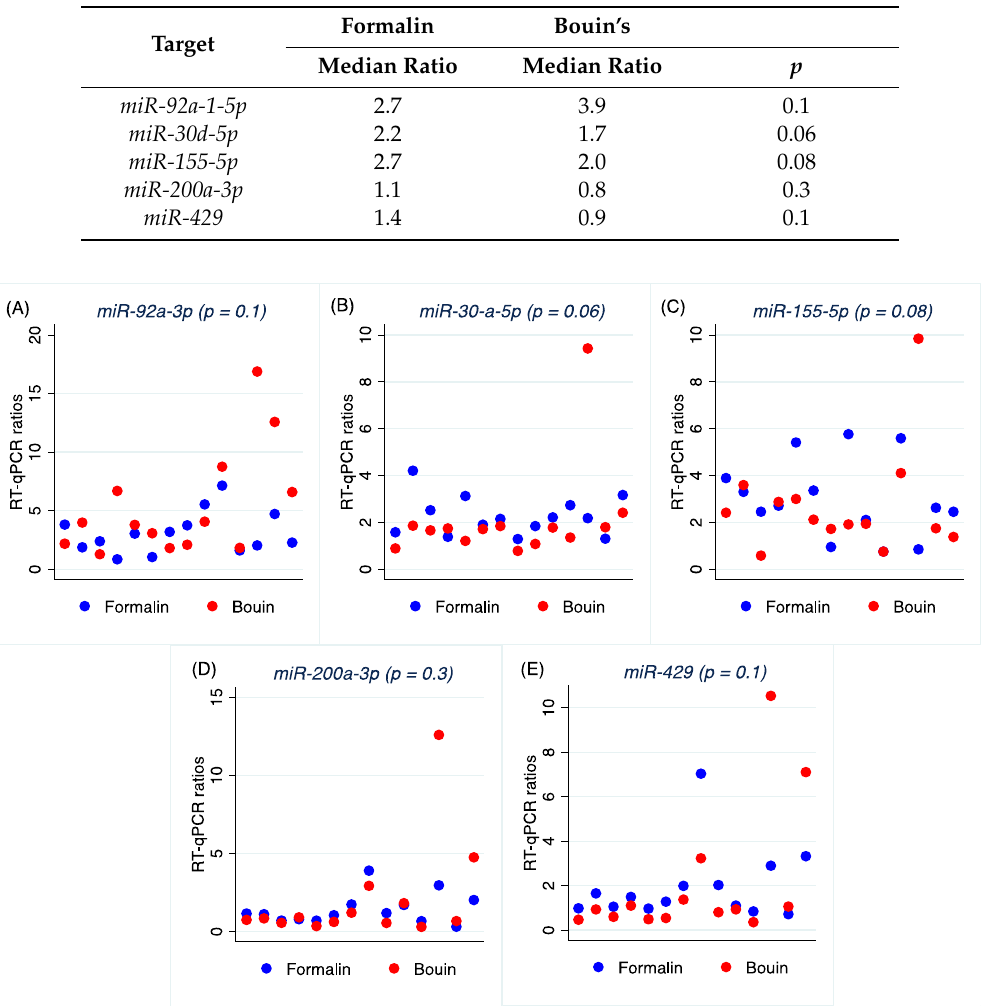
Table 5. Results on RT-qPCR data normalization in paired formalin- and Bouin’s-fixed tissues.